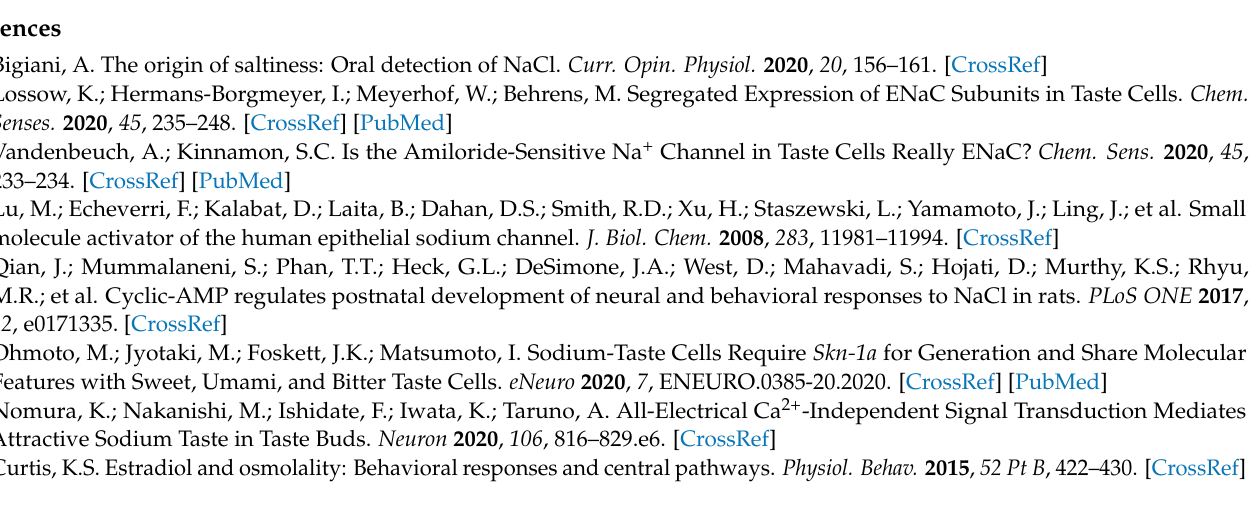
PLC β 2 antibody binding. Scale bars = 50 µ m; Figure S2: TRPV1 mRNA sequence. TRPV1 mRNA RT- PCR product; Figure S3: Western blots for GPER1, TRPV1, and ACE2 in male, female and OVX female mouse gastric smooth muscle (MGSM) and HBO cells lysates; Figure S4: Co-immunoprecipitation (co-IP) studies of GPER1/AT1R, GPER1/TRPV1 and GPER1/ACE2 in mouse gastric smooth muscle (MGSM) and GPER1/ENaC in HBO cell